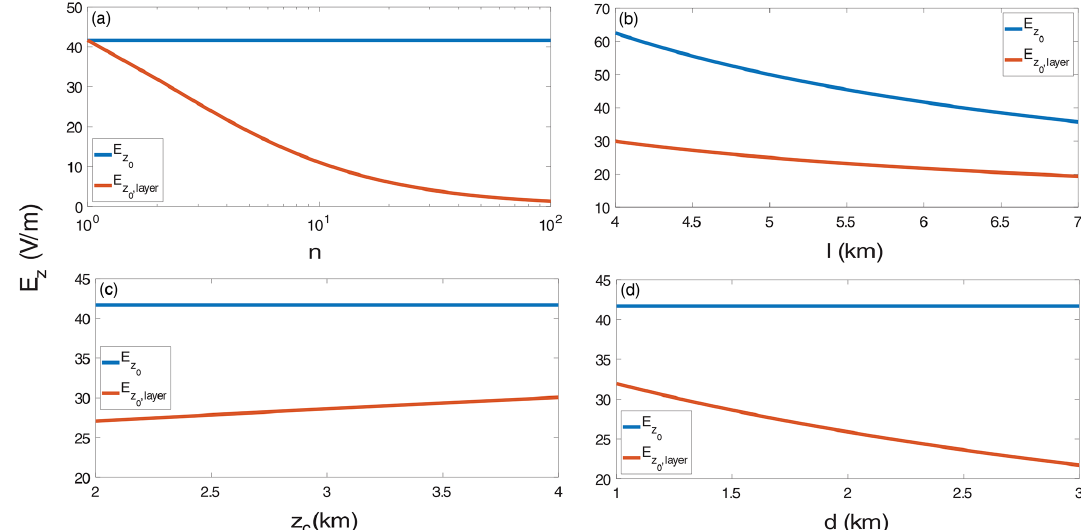
Figure A1. Dependence of the vertical electric field at ground level, under fair weather ( E z uncharged dust layer ( E z , red line) on (a) the reduction factor n , (b) the scaling height l , (c) the central layer height z c and (d) the dust 0 , layer layer depth d , for 1 /σ 0 = 3 × 10 13 (cid:127) m, V ion = 250kV and H = 70